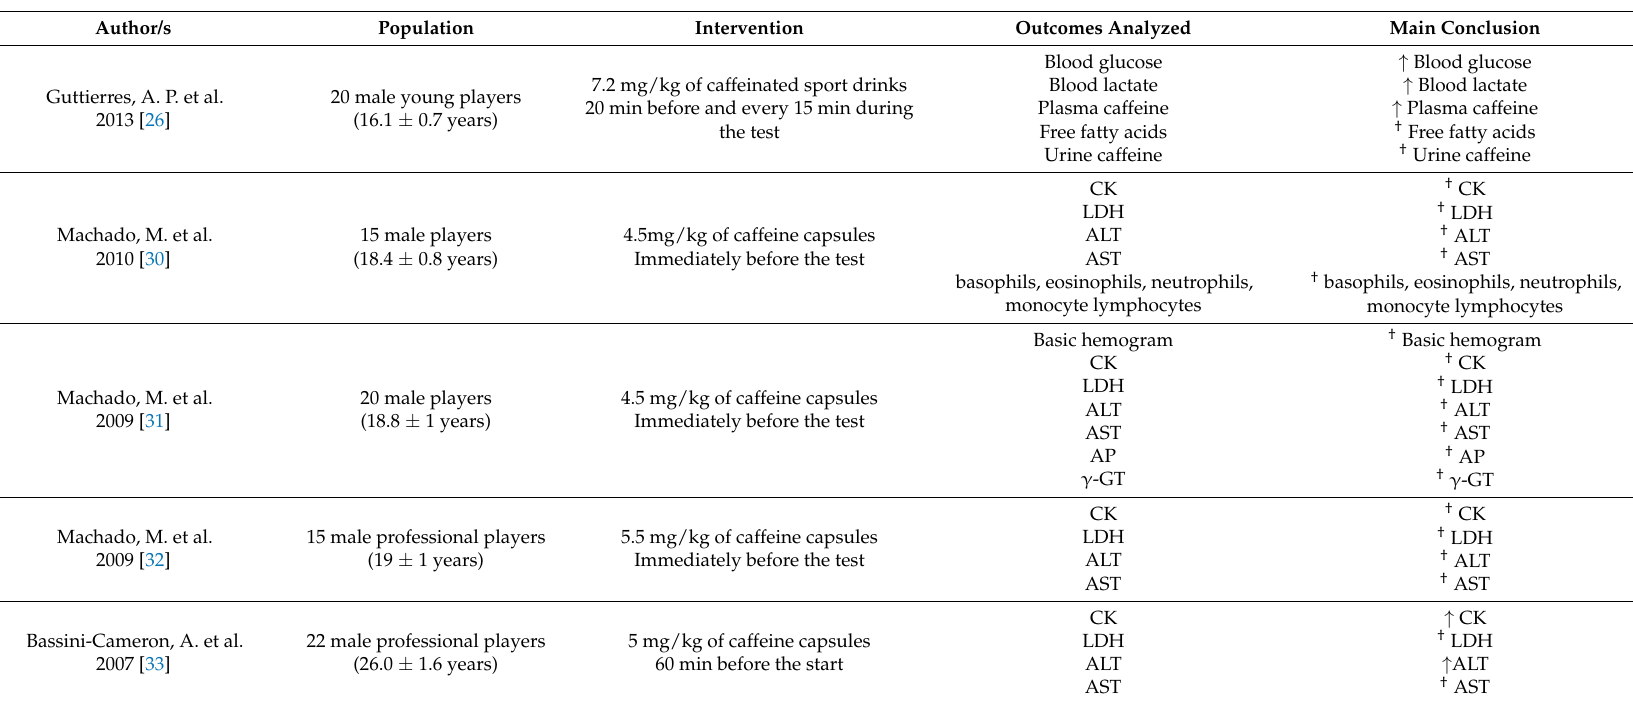
Table 2. Summary of studies included in the systematic review that investigated the effect of caffeine ingestion as compared to a placebo on serum markers of muscle